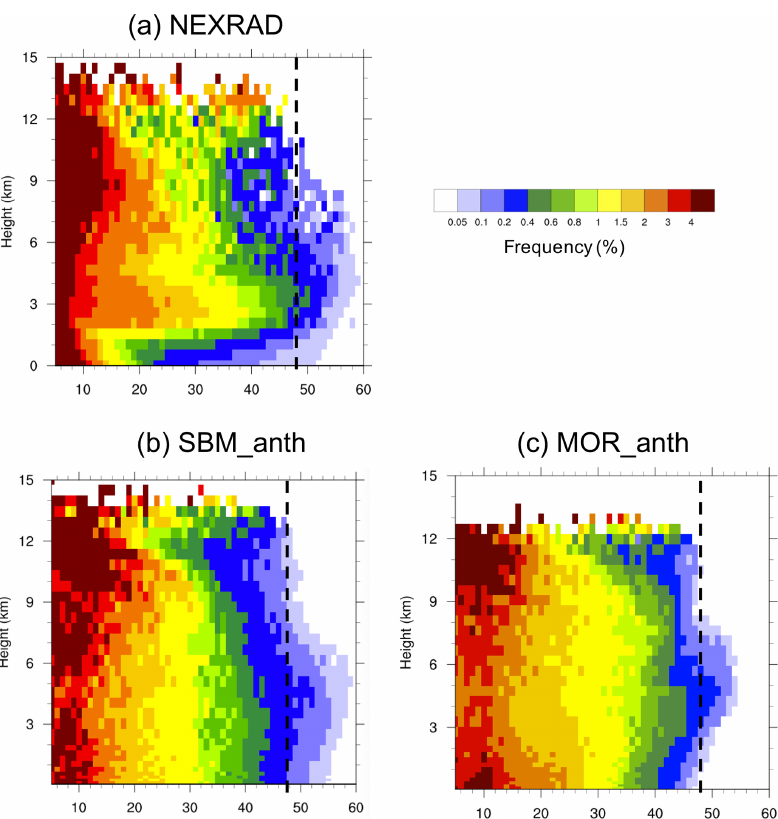
Figure 8. The CFAD of reflectivity (unit:dBZ) for values larger than 0dBZ from (a) NEXRAD, (b) SBM_anth, and (c) MOR_anth over the study area (red box in Fig. 7) from 18:00UTC on 19 June to 00:00UTC on 20 June 2013. The black solid lines denote the reflectivity with a value of 48dBZ. The results are the three ensemble means.